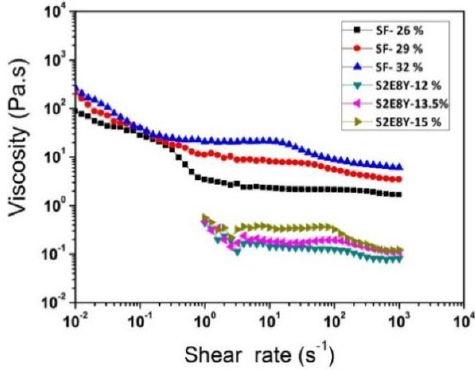
Figure 2. Rheology of SF and S2E8Y solutions with different concentrations.